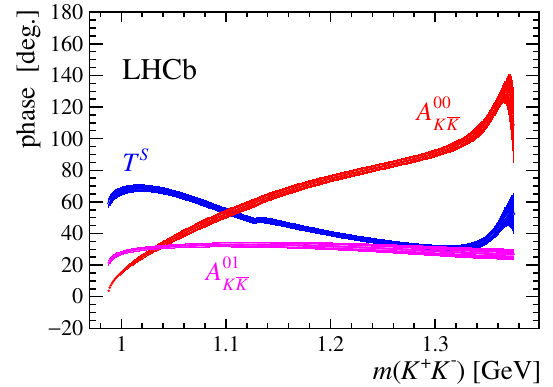
Figure 13 . Phase of the J = 0 component of the decay amplitude (blue) T S = T 00 + T 01 + T S compared to the phases of the scattering amplitudes, (red) A 00 function of the K + K (cid:0) invariant